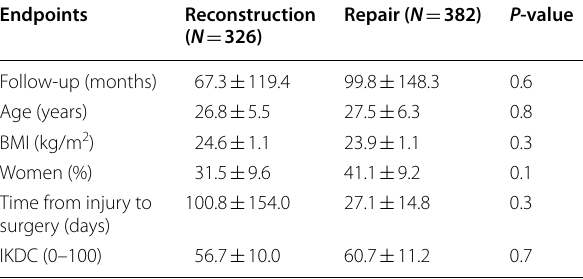
No statistically significant difference was found in the endpoints of interest, indicating good between-groups comparability BMI: body mass index; IKDC: International Knee Document